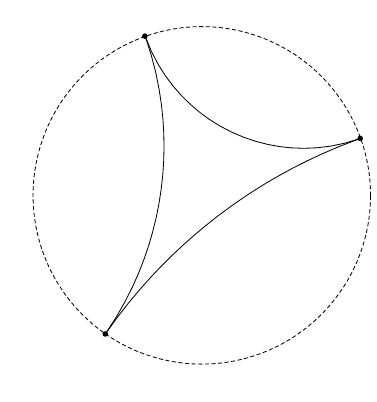
Figure 2 . A large triangle on the Poincare disk. Even though the distance between the three points grows without bound, any point on one side of the triangle is close to some other point on another side of the triangle. The triangle is (cid:14) -thin, where (cid:14) is of order the curvature